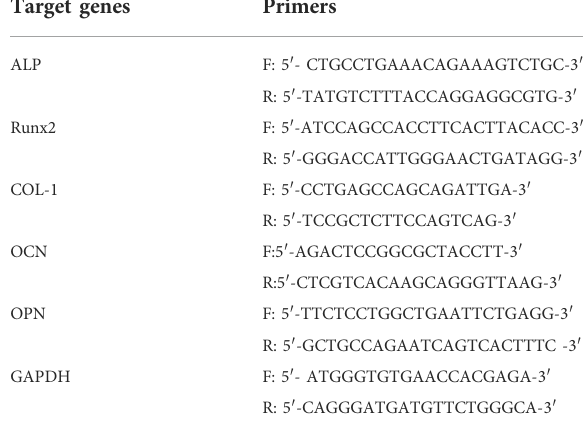
TABLE 1 Primers for target